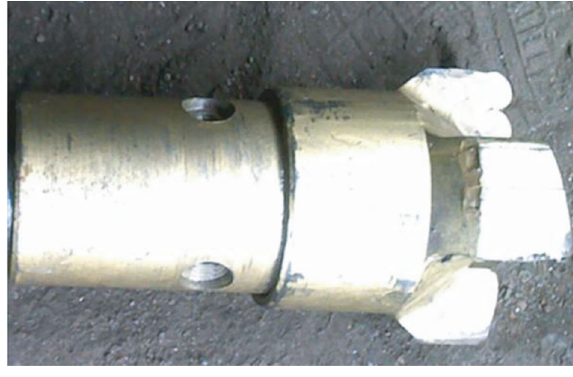
Figure 15: Water jet cutting bit. Table 1: Geometric parameters of the nozzles.